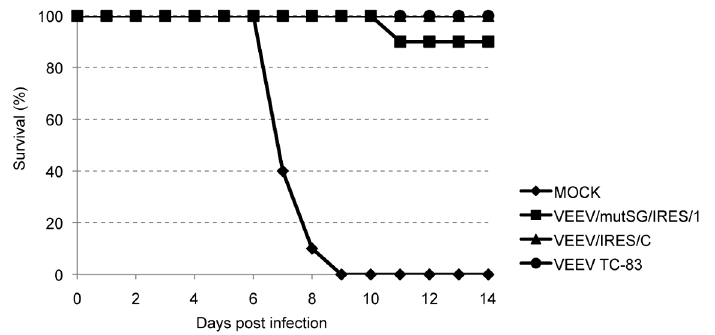
Figure 9. Survival following vaccination and challenge of adult mice. Five-week-old CD1 mice were vaccinated with 10 5 PFU of VEEV TC-83 or IRES-based viruses. Challenge was performed 6 weeks post-vaccination by SC inoculation of 10 4 PFU of VEEV IC strain 3908, with daily monitoring of animals. No deaths occurred after day 11 post-challenge.